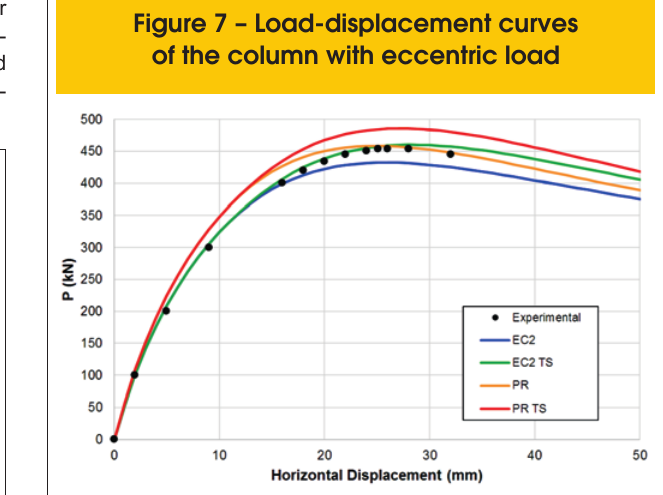
Figure 7 – Load-displacement curves of the column with eccentric